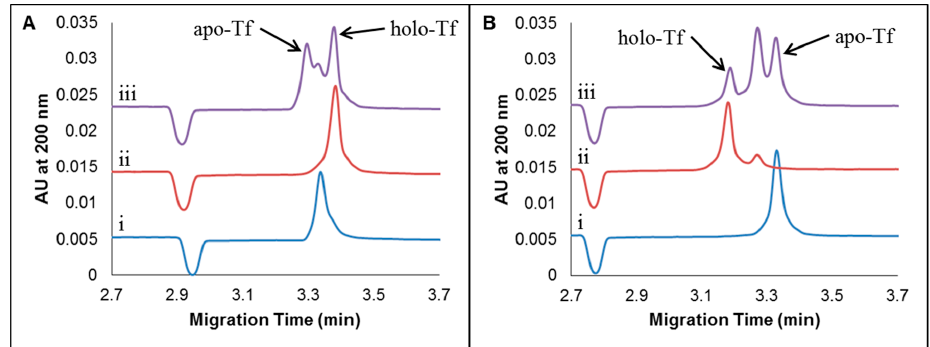
Figure 2. Effects of oven CDs as additives for samples of apo-Tf, holo-Tf and mixtures of apo- and holo-Tf (25 µM each) without CDs ( A ) and with CDs ( B ) for 25 µM apo-Tf (i), 25 µM holo-Tf (ii), and a mixture of apo- and holo-Tf (iii). Electropherograms are vertically offset for clarity. A volume of 1.25 nL (5.2 sec at 1.3 psi) was injected and 20 kV was applied. The separation occurred on a Beckman Coulter P/ACE MDQ System coupled with a UV detector at 15 °C on a 25 µm i.d. capillary with an effective length of 30 cm and a total length of 40 cm.